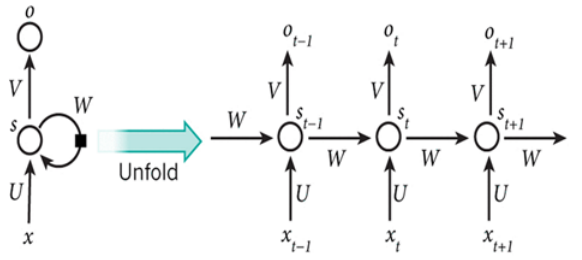
Figure 1. Schematic diagram of an RNN.